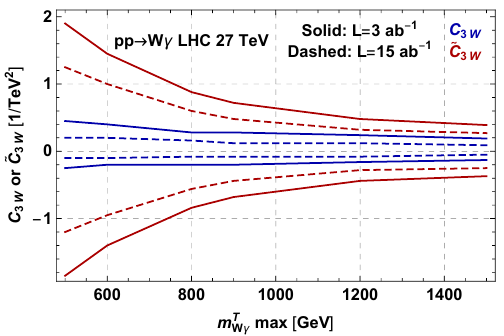
Solid: L = 3 ab - 1 Dashed: L = 15 ab - 1